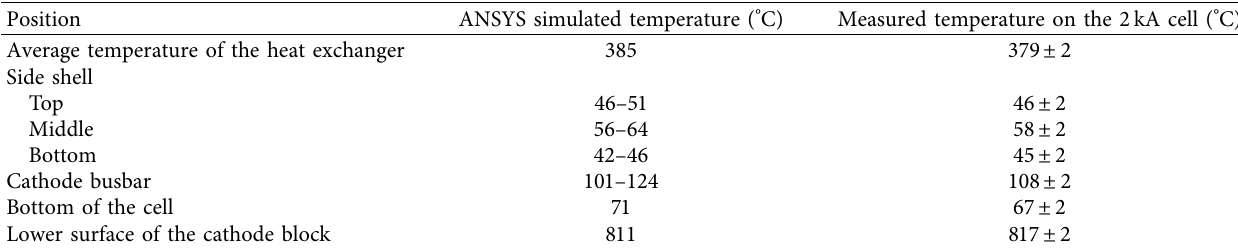
Figure 7: ANSYS simulation results of the heat-flux vectors in the 2 kA laboratory heat-exchanging cell. Table 2: Comparison of the measured temperature values and ANSYS simulation results.